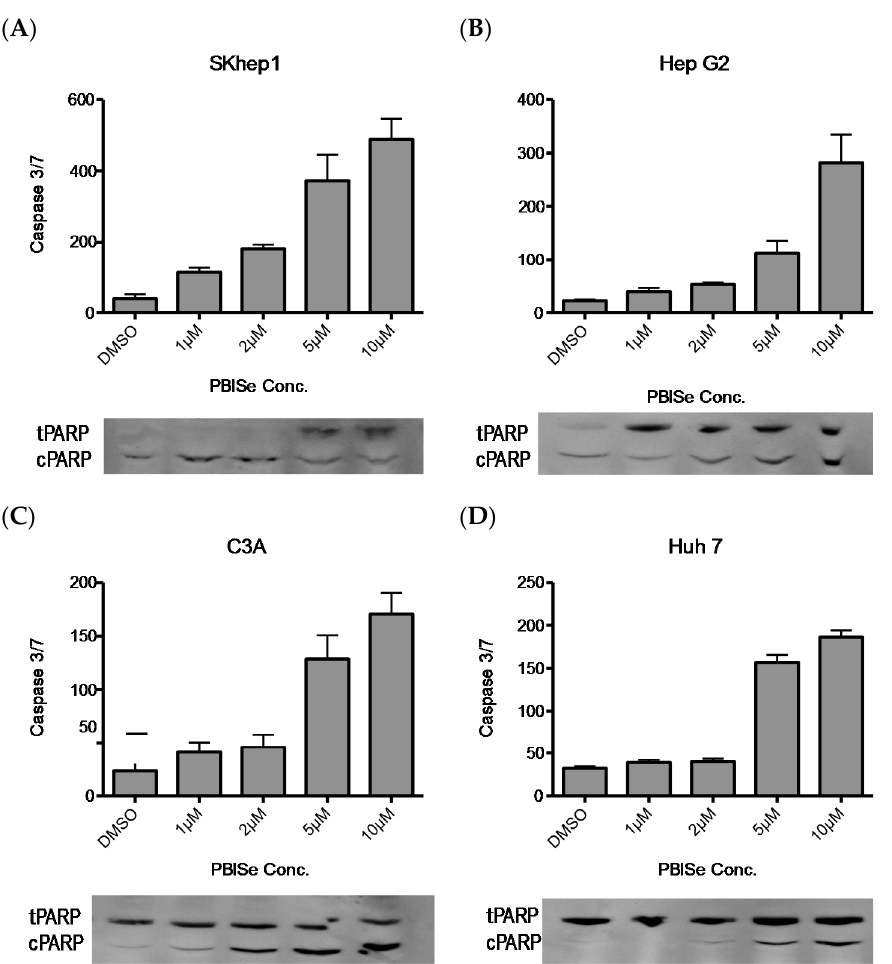
Figure 2. PBISe induces caspase dependent apoptosis of human HCC in a dose-dependent fashion. Four different cell lines were used to demonstrate the apoptotic process. ( A ) Skhep1; ( B ) HepG2; ( C ) C3A; ( D ) Huh-7. HCC cells were seeded onto 96-well plates (5 × 10 3 /well) in MEM with 10% FBS and allowed to attach overnight. Cells were then treated with PBISe or DMSO at indicated concentrations the following day, as shown in the figure. After 48 h of treatment, cell apoptosis assays were performed using Apo-one Homogeneous Caspase-3/7 Assay (Promega) according to the manufacturer’s instructions. n = 3; error bar represent Mean ± S.E. The protein expression of cleaved PARP analysis was performed by Western blot analysis as shown in figure for all cell lines.